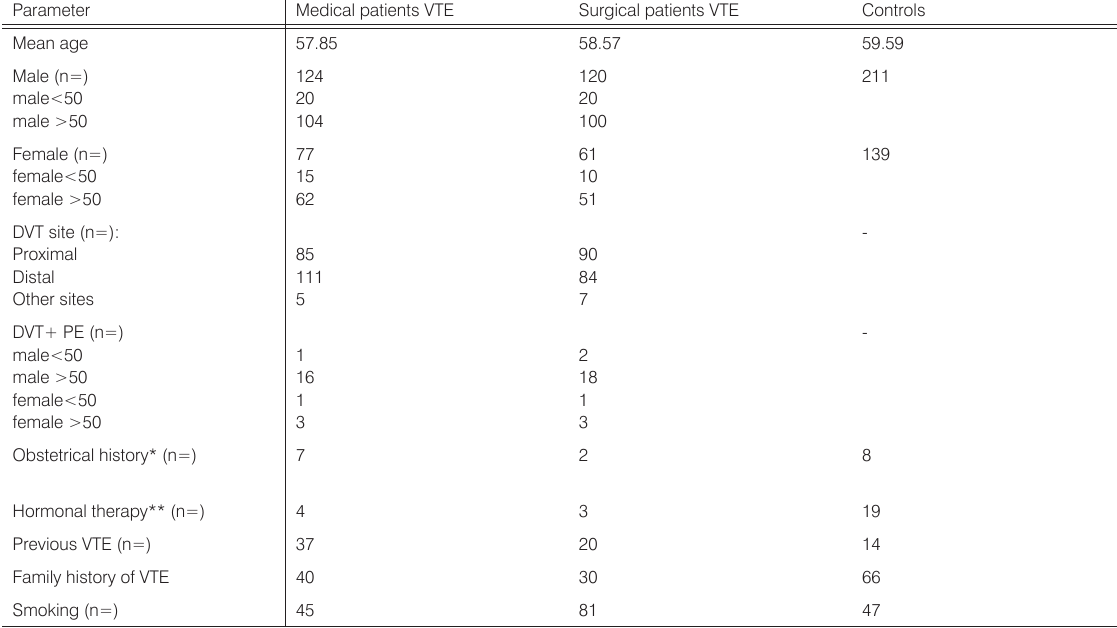
Table 1. Demographic characteristics of the medical and surgical patients with VTE, and the controls